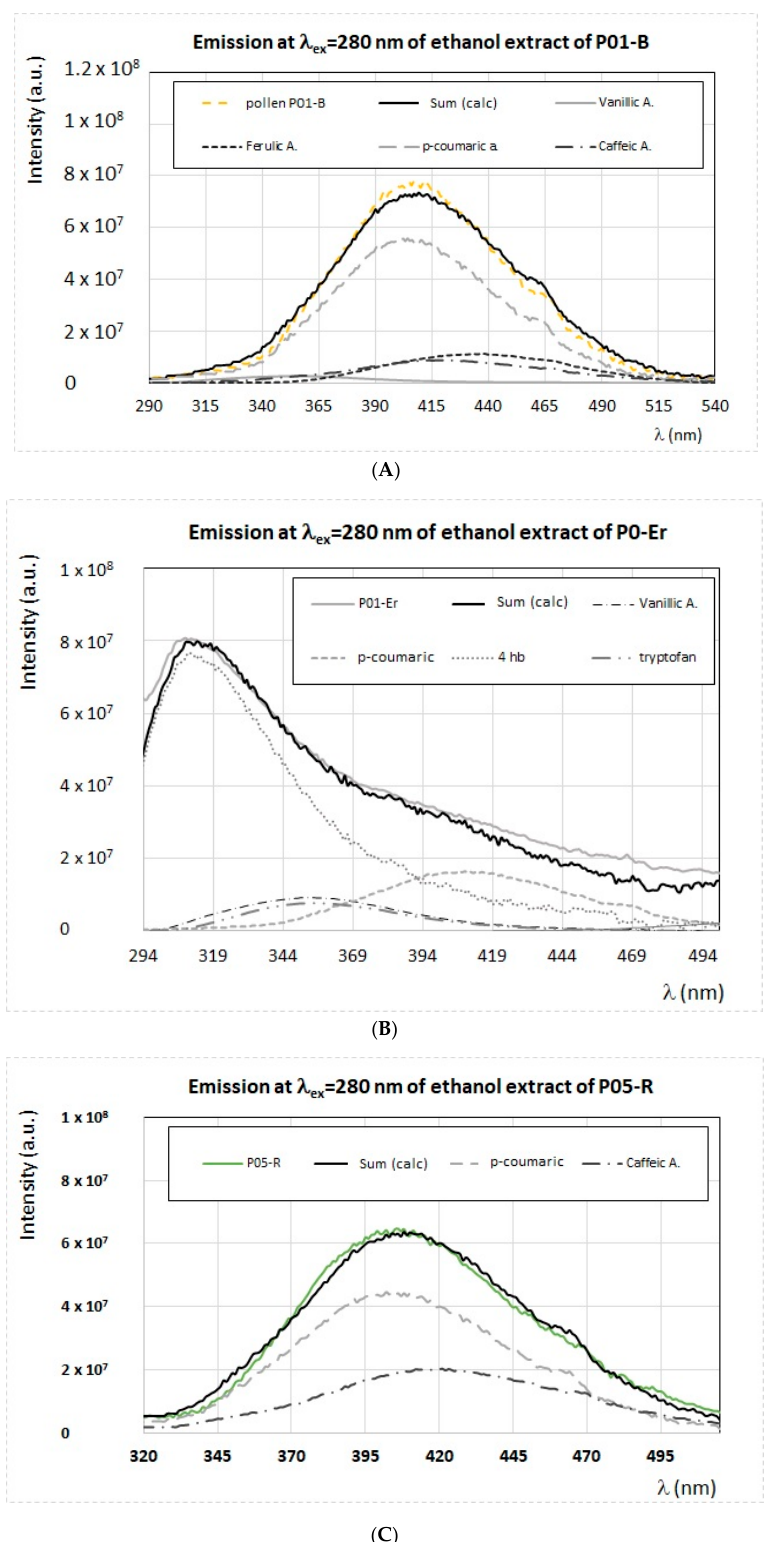
Figure 4. ( A – C ) Experimental and calculated FFF emission spectra of the ethanol extracts obtained from the samples P01-B ( A ), P01-Er ( B ), and P05-R ( C ), prepared as described in the main text, obtained by exciting the sample at λ ex = 280 nm. The calculated spectra, indicated as Sum (calc), are obtained as the sum of di ff erent components: ferulic acid, p-coumaric acid, ca ff eic acid, vanillic acid, 4-hydroxybenzoic acid (4 hb), and